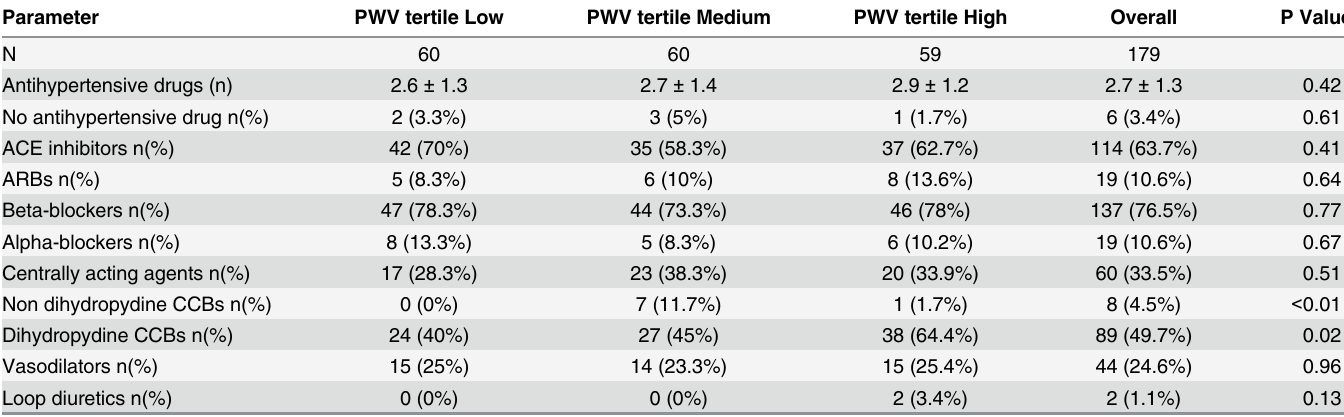
Table 2. Number and class of antihypertensive medications according to the tertile of aortic pulse wave velocity. Parameter